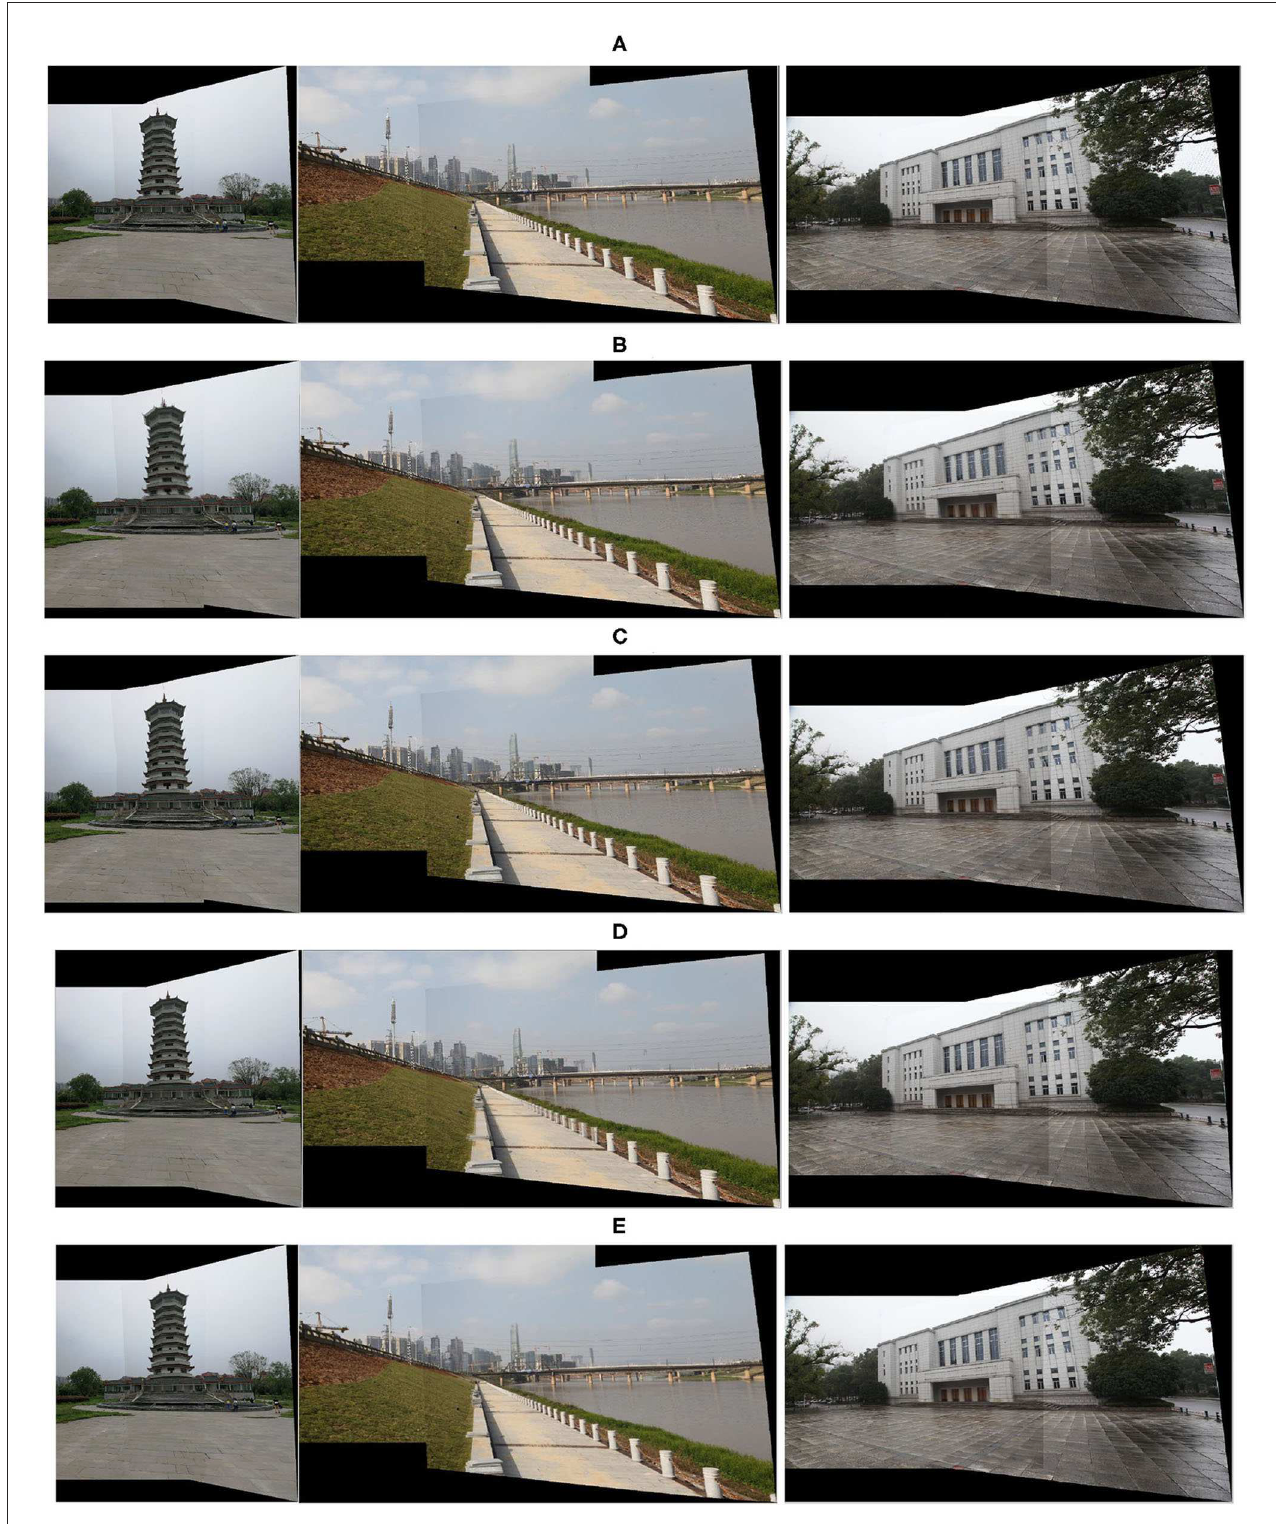
FIGURE7 Comparison results for different scenes. From top to bottom, the image stitching results are (A) our method, (B) global homography, (C) APAP, (D) AutoStitch, and (E) SPW, respectively. Here, from left to right, the scenes are the tower , riverbank , and theater